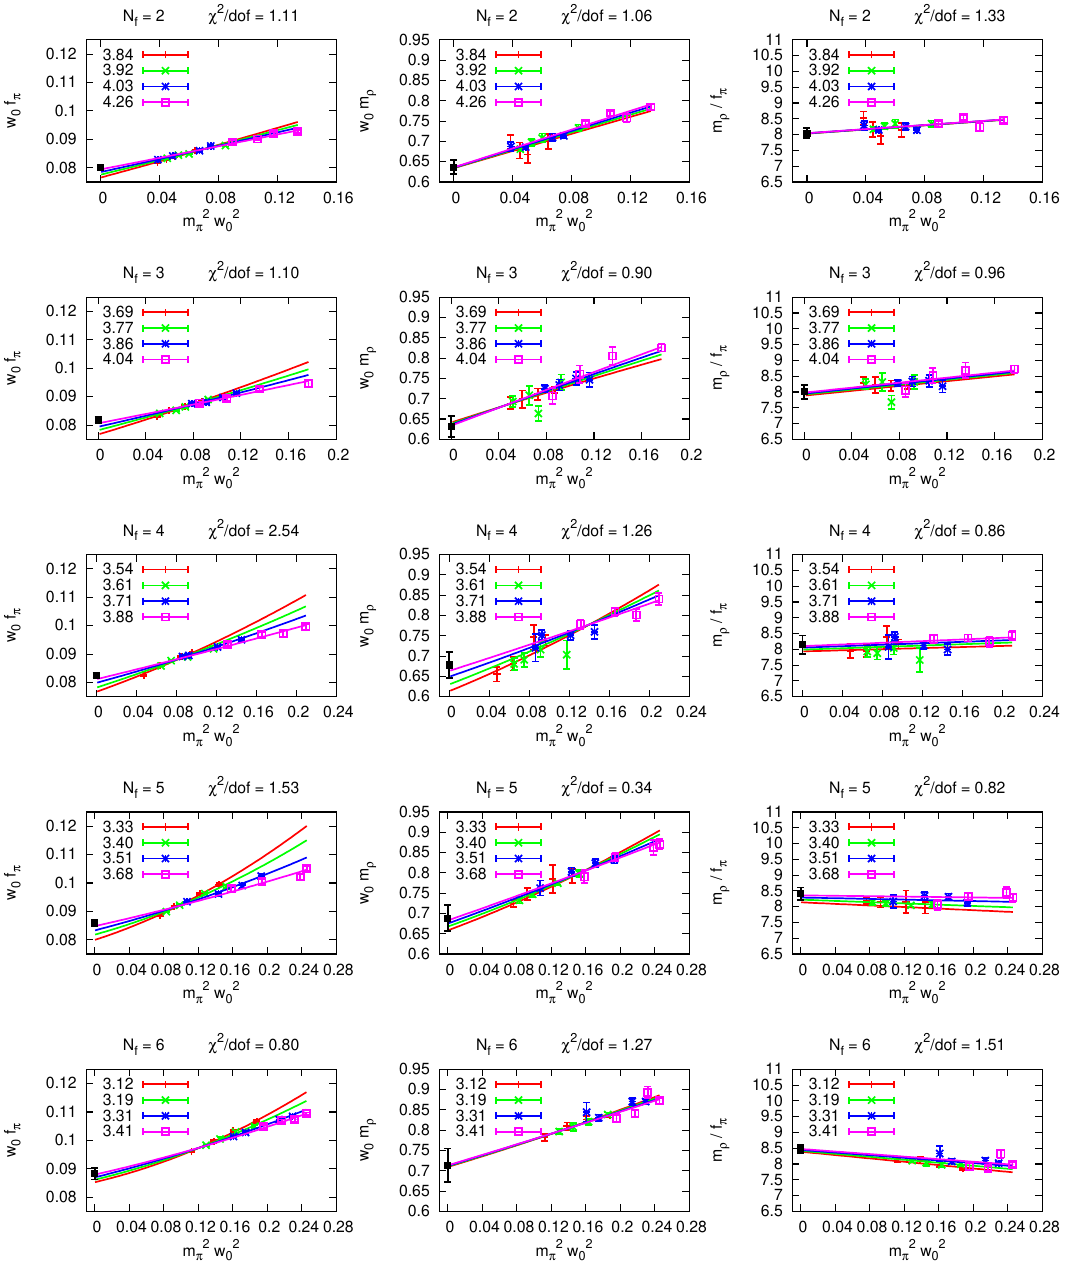
Figure 3 . Chiral-continuum extrapolation of f (cid:25) w 0 , m % w 0 (left two columns) and directly the ratio m % =f (cid:25) (right most column) for N f = 2 ; 3 ; 4 ; 5 and 6, from top to bottom, respectively. Equa- tions (4.3) and (4.4) are used and the resulting (cid:31) 2 =dof is shown at the top of each plot. The various colors correspond to di(cid:11)erent lattice spacings (i.e. di(cid:11)erent bare (cid:12) ) and were obtained by interpolations of a 2 =w 2 as a linear function of m 2 w 2 together with equations (4.3) and (4.4); see (cid:25) 0 0 text for more details.